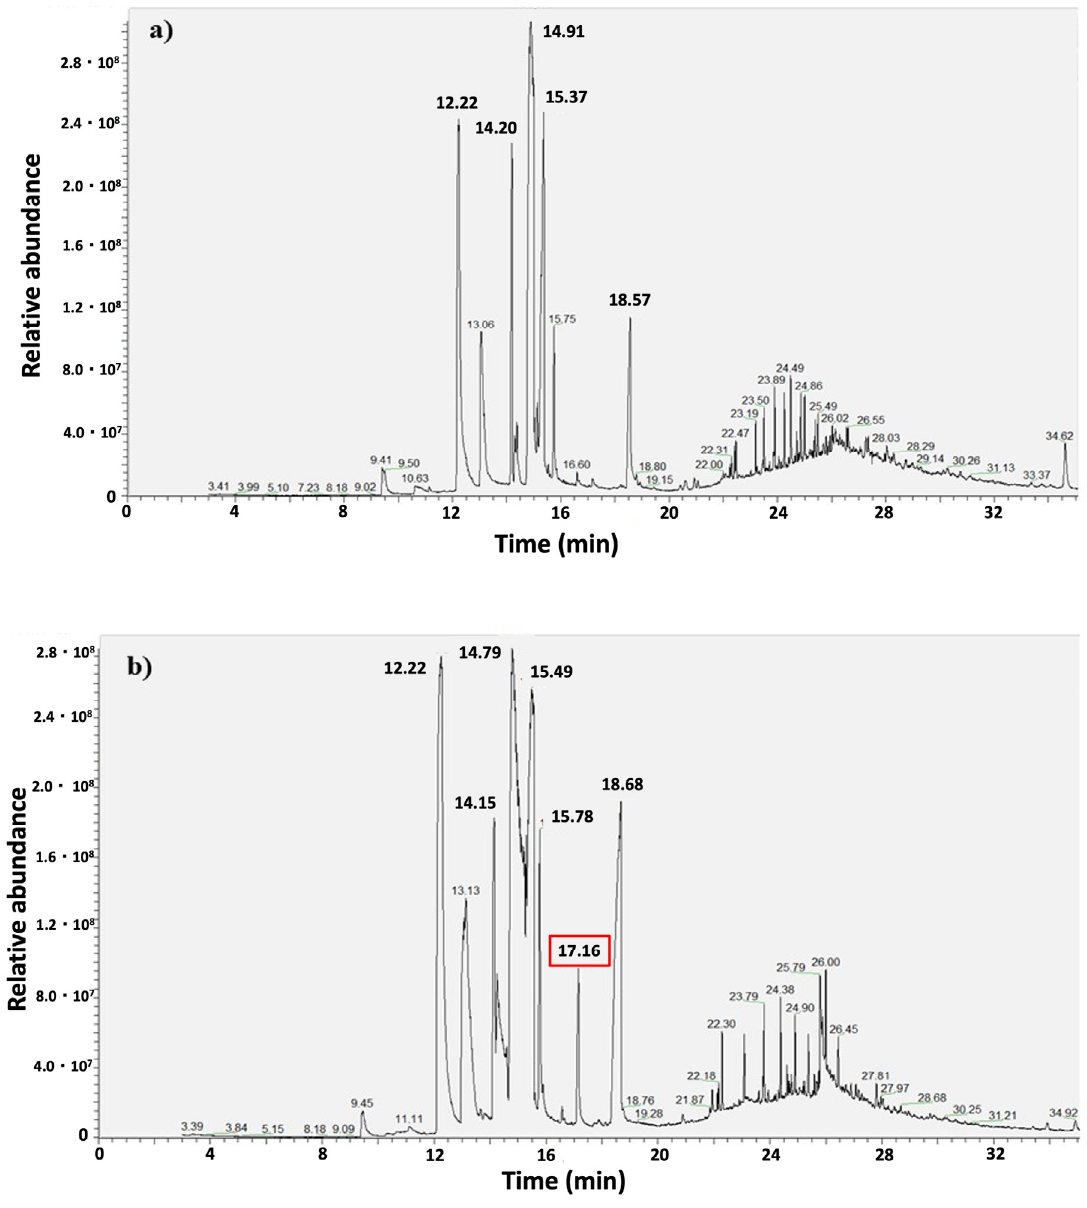
Figure 5. Chromatograms of control ( a ) and exposed samples ( b ). Exposed samples differ from the controls for the peak at 17.16 min, identifying